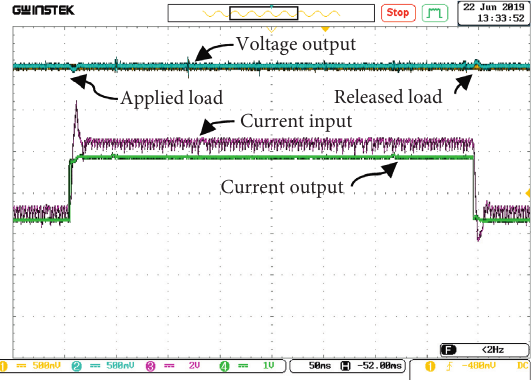
Figure 26: Response of voltage and current using a PI controller with TS search.